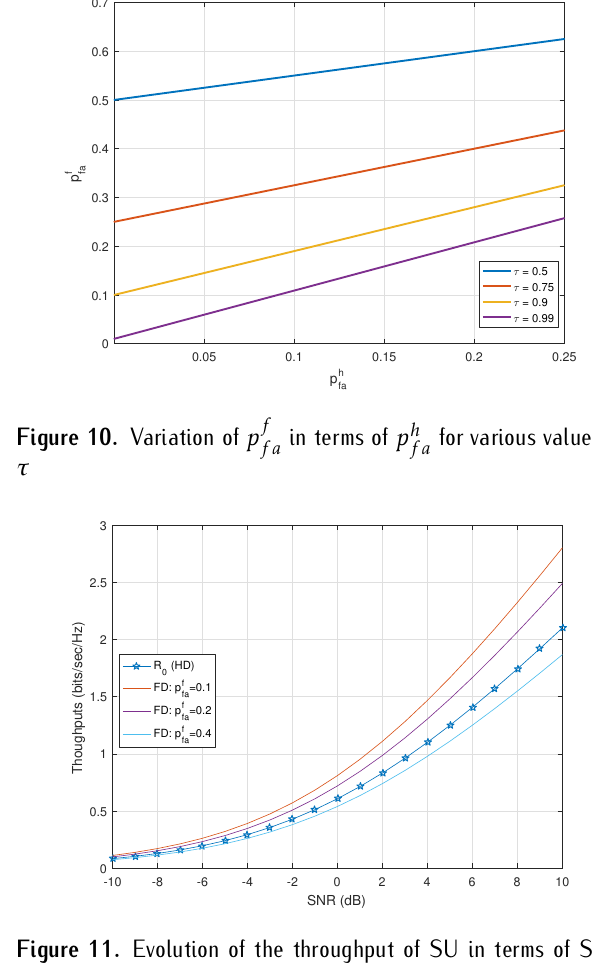
Figure 11. Evolution of the throughput of SU in terms of SNR (dB) for HD and FD